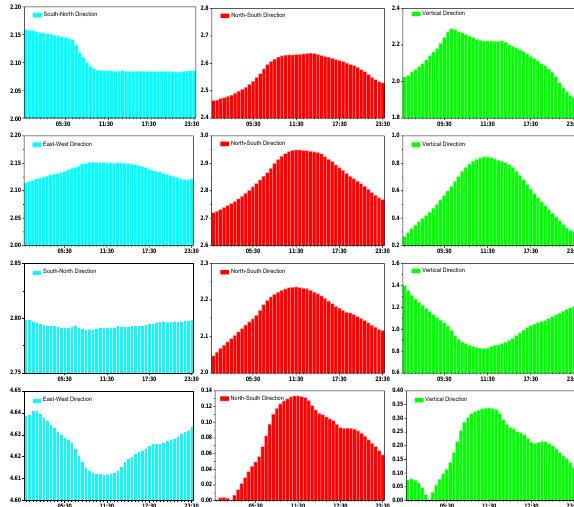
Figure 10. Daily vibration acceleration in four seasons(mm/s 2 )